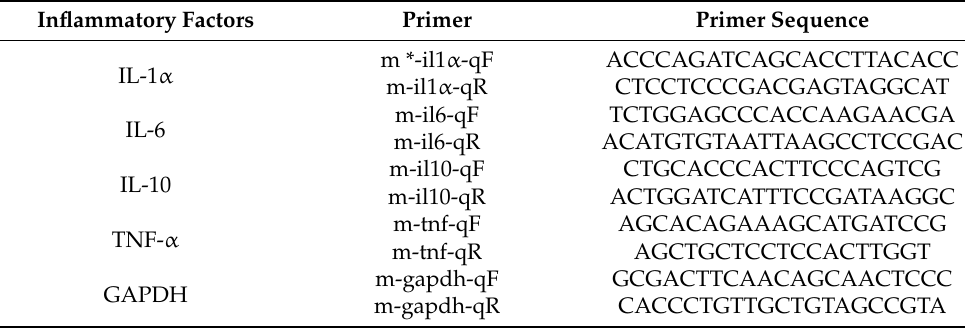
Table 2. The primer sequences of real-time quantitative PCR.